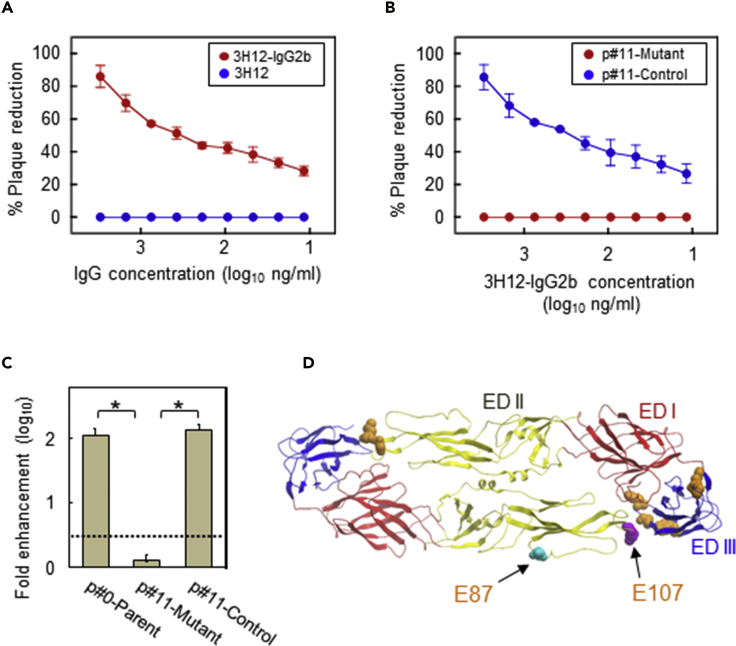
Identification of Amino Acid Substitution Sites in a Neutralization-Escape Mutant(A) Neutralizing activities of 3H12-IgG2b antibody against DENV-1 Mochizuki. The x axis shows the 3H12-IgG2b or 3H12 concentration, and the y axis shows the percentage of plaque reduction.(B) Neutralizing activities of 3H12-IgG2b against an escape mutant obtained after 11 passages (p#11-Mutant) and the corresponding control (p#11-Control). The x axis shows the 3H12-IgG2b concentration, and the y axis displays the percentage of plaque reduction.(C) Infection-enhancing activities of 3H12 against the p#11-Mutant, p#11-Control, and p#0-Parent, expressed as the fold enhancement in the presence of 1 μg/mL of 3H12. Dotted lines indicate the cutoff differentiating enhancing from non-enhancing activities. Data represent averages of two independent assays ± SD (*p < 0.001).(D) Positions 87 and 107 of E (Protein DataBank accession code: 1UZG) with indication of three domains. EDI, EDII, and EDIII are indicated in red, yellow, and blue, respectively. Two key amino acid residues (epitopes) are indicated in green (D87N) and purple (L107F). For reference, a flavivirus-cross-reactive mAb 4G2, which recognizes residues in the E protein, is shown in orange (Crill and Chang, 2004; Chiou et al., 2012) on the other side of the E homodimer.